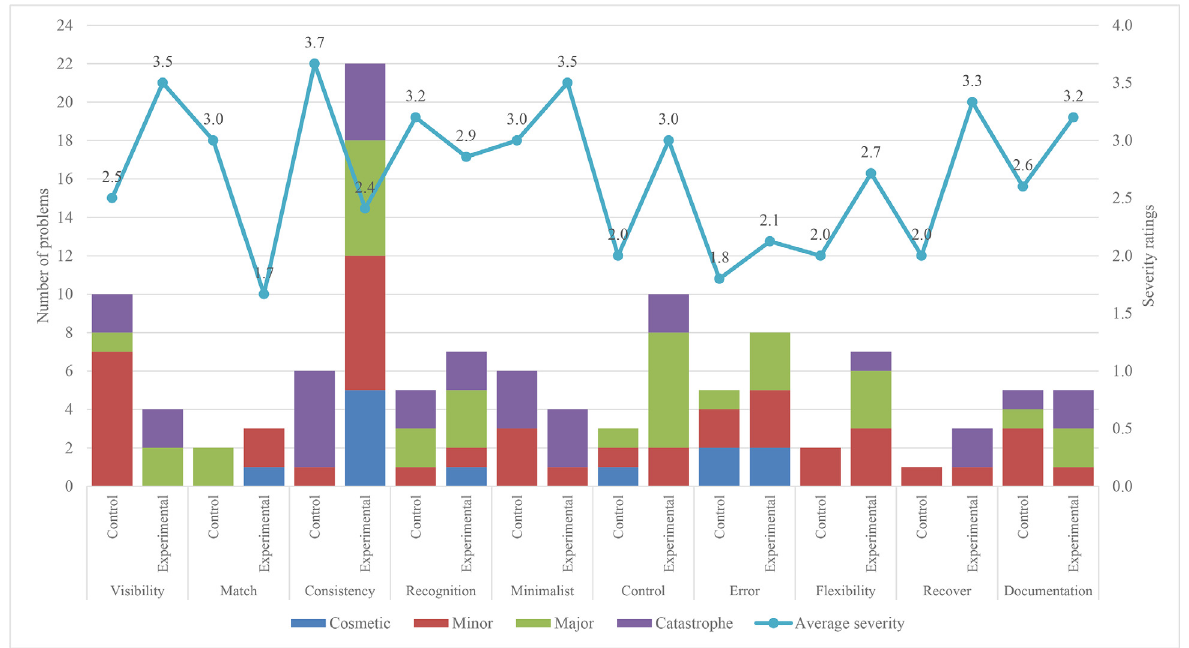
Fig 5. Number of usability problems and average severity ratings found in System 1 by both